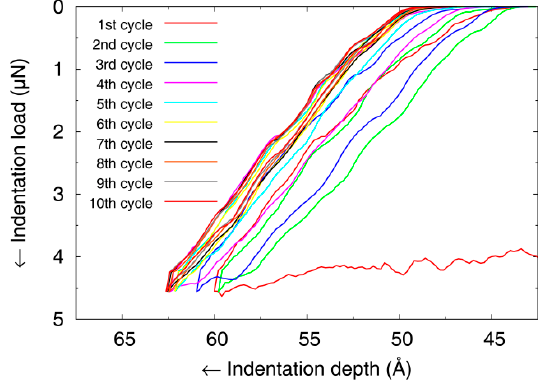
Figure 13. Load-depth curves during cyclic indentation (10 loading–unloading cycles).